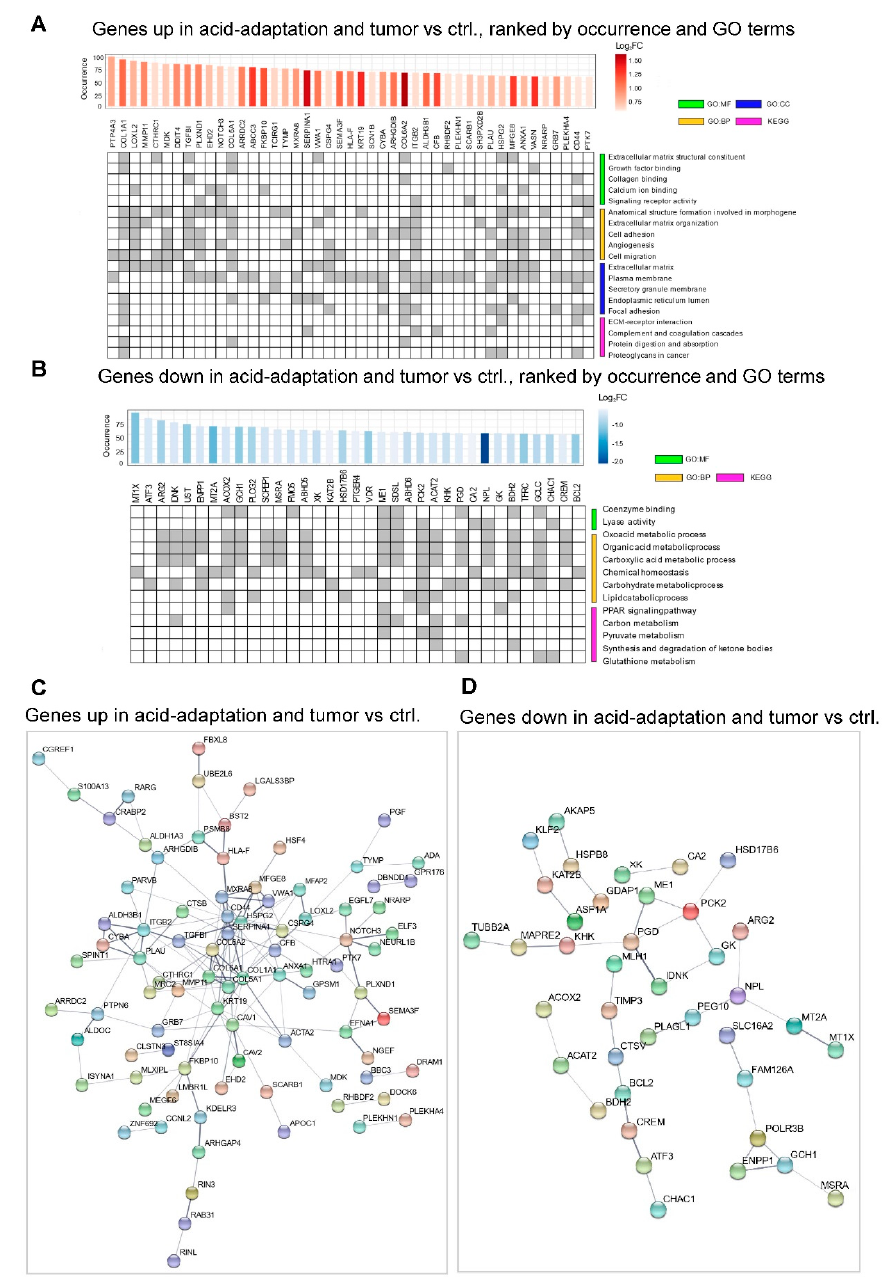
Figure 5. Analysis of overlapping genes between pH ranks and tumor–ctrl. ranks with high similarity. ( A ) Gene ontology (GO) and KEGG pathway analysis of genes upregulated in acid adaptation and correlated in gene expression rank in tumor–ctrl. comparisons in ≥ 50 patients. The upper bar plot shows the number of tumor–ctrl. vs. acid adaptation RRHO analyses in which the gene was identified as significant. Bar color indicates log 2 expression FC in the acid adaptation experiment (pH 6.5 vs. 7.6). Gene identifiers are shown below. Rows in the bottom panel correspond to selected GO terms with high significance from three sources (BP—Biological process, MF—Molecular function, CC—Cellular Component) and pathways from the KEGG database. Columns are genes as indicated above. Grey cells indicate that a given gene is labelled with a given GO term or pathway. ( B ) Gene ontology (GO) analysis of genes downregulated in acid adaptation correlated in gene expression rank in tumor–ctrl. comparisons in ≥ 50 patients, arranged as in ( A ). ( C ) STRING database analysis of genes from panel ( A ). Nodes are genes. Connections indicate STRING database evidence of protein interaction. Fully unconnected genes are not shown. ( D ) STRING database analysis of genes from panel ( B ), arranged as in ( C